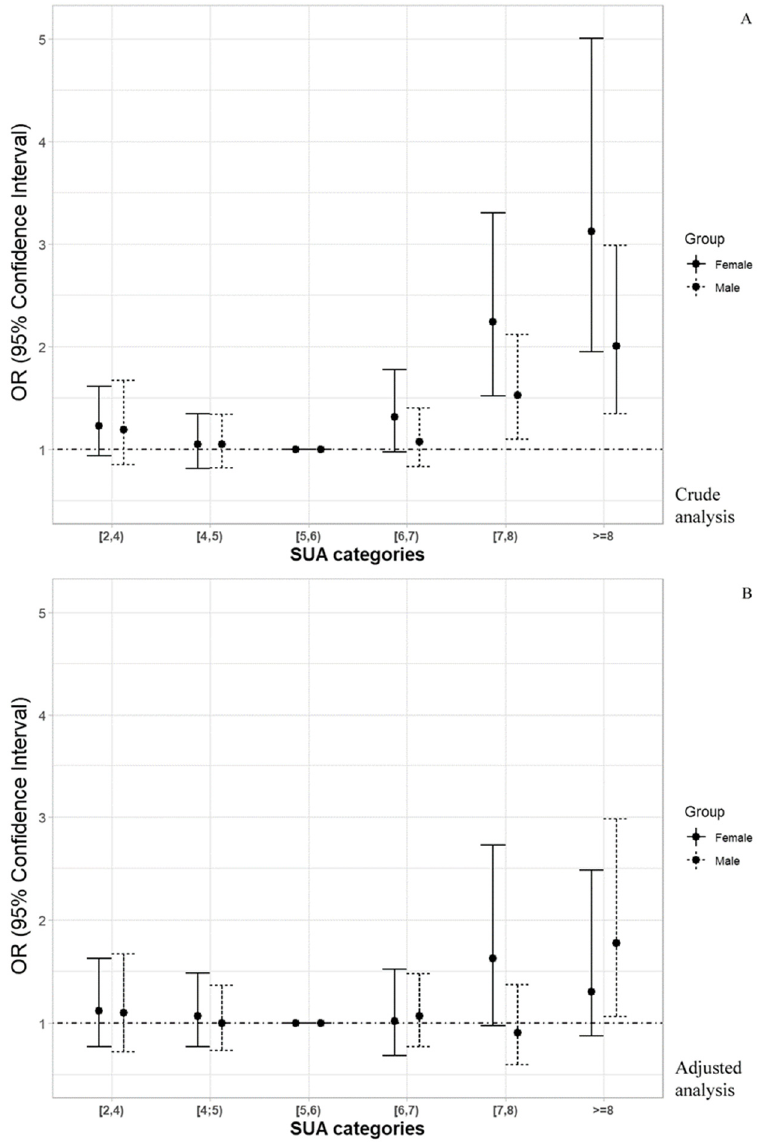
Figure 4. Risk of death (odds ratios with 95% confidence intervals) according to SUA levels subgroups. ( A ) The crude analysis; ( B ) The adjusted